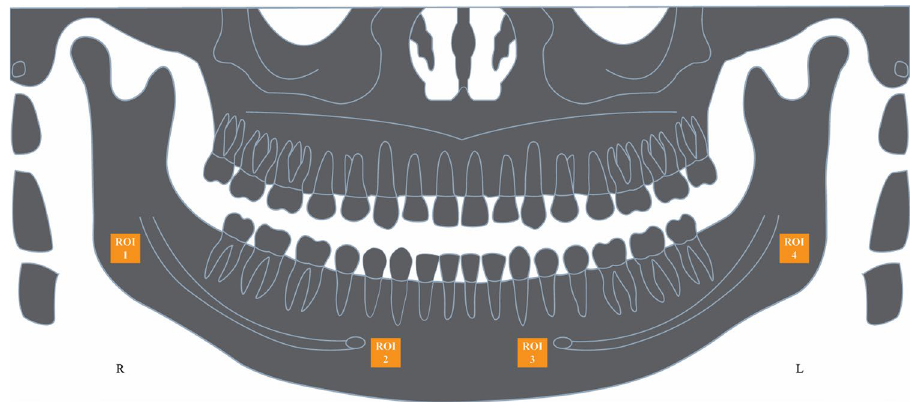
Figure 1. Schema on the elected regions of interest (ROI). ROI 1 right mandibular angle, ROI 2 in the trabecular bone, 2 mm anterior to right mental foramen, ROI 3 in the trabecular bone, 2 mm anterior to left mental foramen, ROI 4 left mandibular